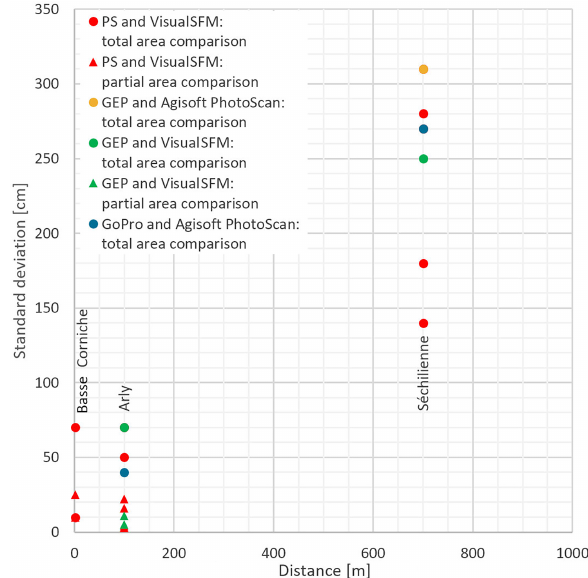
Figure 9. Correlation between the distance from the camera to the case studies and the expected standard deviation from the three case studies. The dots are results of point cloud comparisons on the en- tire point cloud areas (Table 1). The triangles are the results of point cloud comparisons on partial point cloud area (Table 2). The red dots and triangles are the results of the three case studies’ point clouds obtained from Google Street View (GSV) print screens (PS) in Google Maps (GM), processed with VisualSFM compared on the entire area. The orange dot is the result of the Séchilienne point cloud obtained from GSV images saved in Google Earth Pro (GEP) processed with VisualSFM. The green dots and triangles are the re- sults of the Séchilienne and Arly point clouds obtained from GSV images saved in GEP, processed with Agisoft PhotoScan. To com- pare, the blue dots represent the result of the Séchilienne and Arly point clouds obtained with GoPro action camera images taken on the field and processed with Agisoft